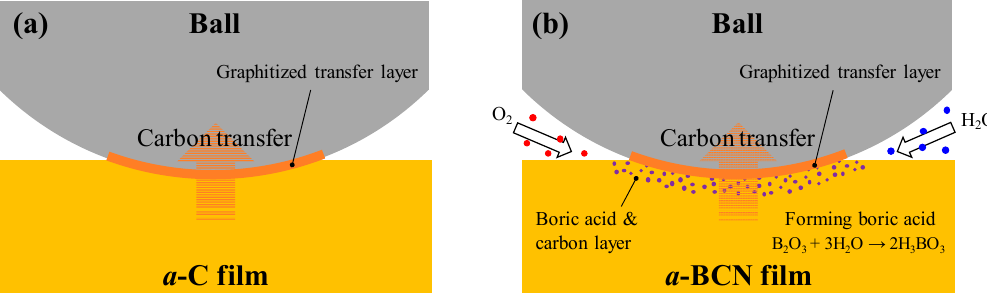
Figure 13. ( a ) Raman spectra of the surface of the as-deposited film, wear track, and ball sample and the corresponding ( b ) Raman parameters.